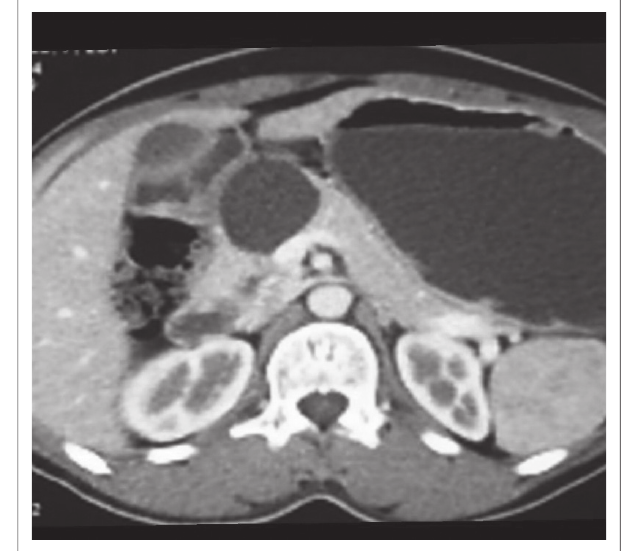
FIGURE 6: Axial contrast-enhanced computed tomography image in a 25-year- old male patient showing a simple pancreatic cyst. No septation or wall enhancement seen. Main pancreatic duct is not